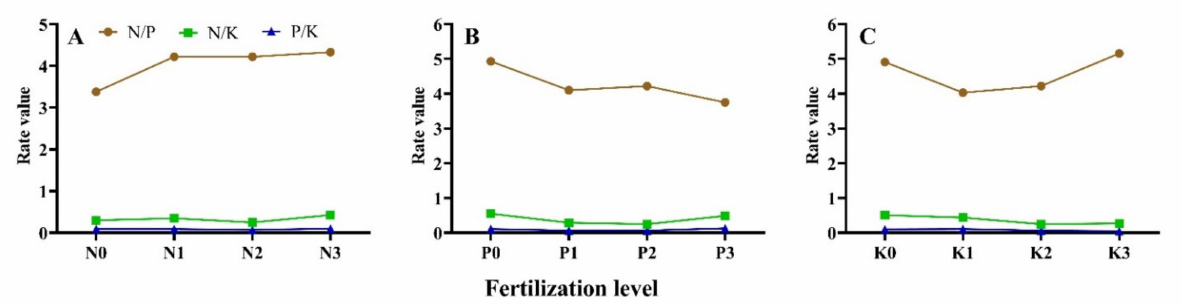
Figure 7. Changes of N, P, and K element absorption balance in P. bournei seedlings under the single-factor of N, P, and K fertilizer. ( A ): the single-factor of N fertilizer; ( B ): the single-factor of P fertilizer; ( C ): the single-factor of K